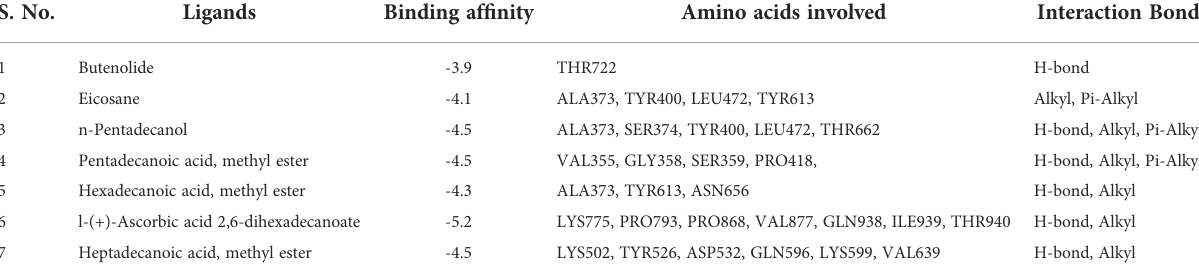
TABLE 5 The docking result of the compounds identi fi ed in the biomass extract of the bacterium Alcanivorax sp. S.